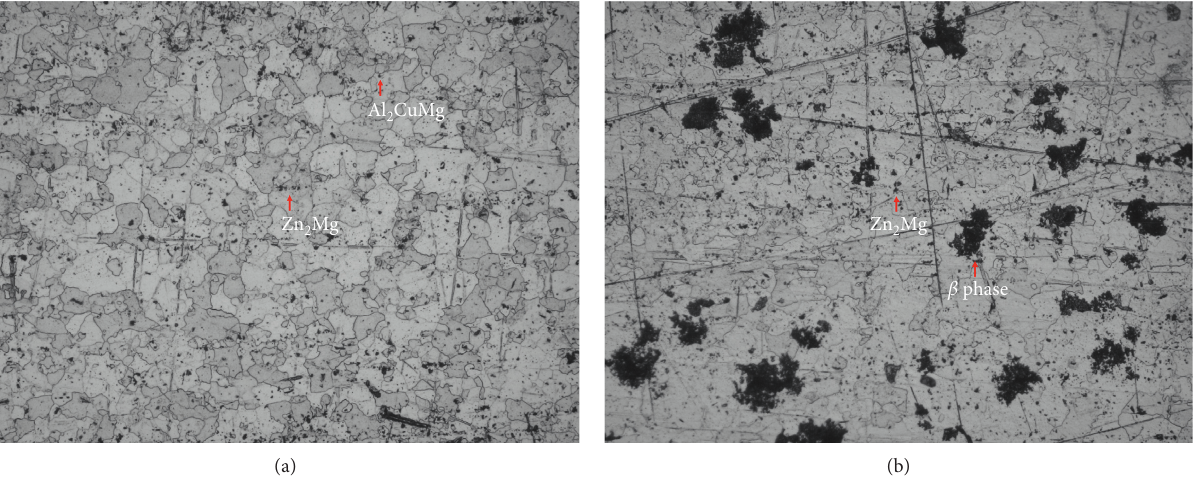
Figure 14: (a) Crack initiation. (b) Crack obvious propagation.